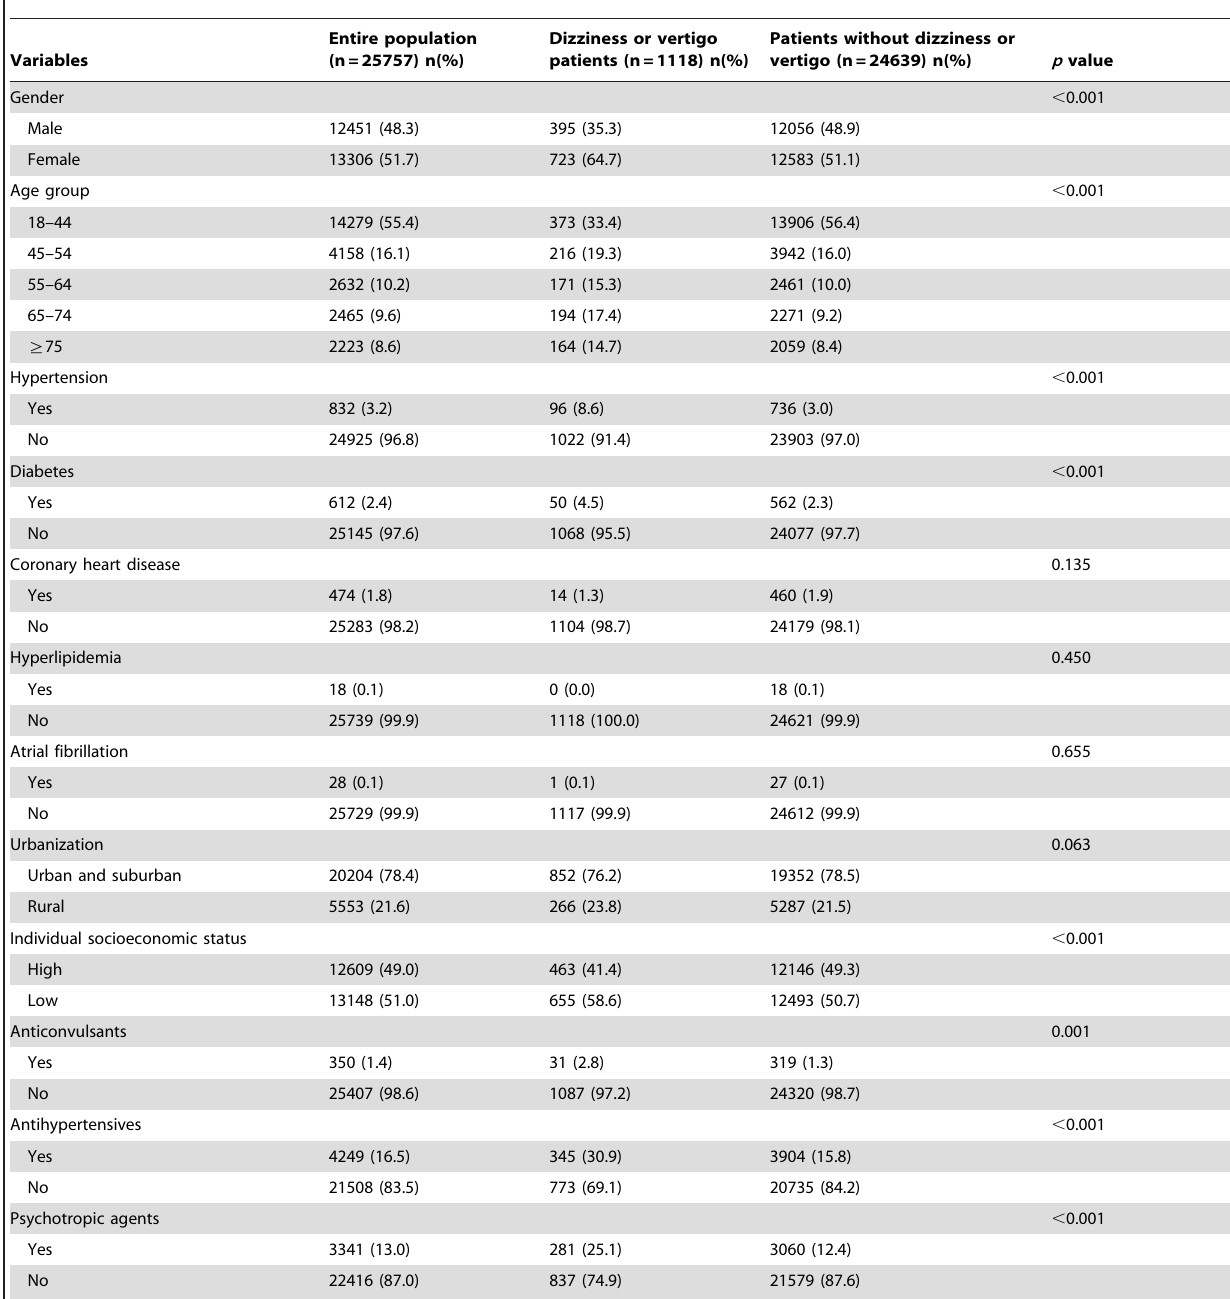
Table 1. Baseline characteristics of the study population.